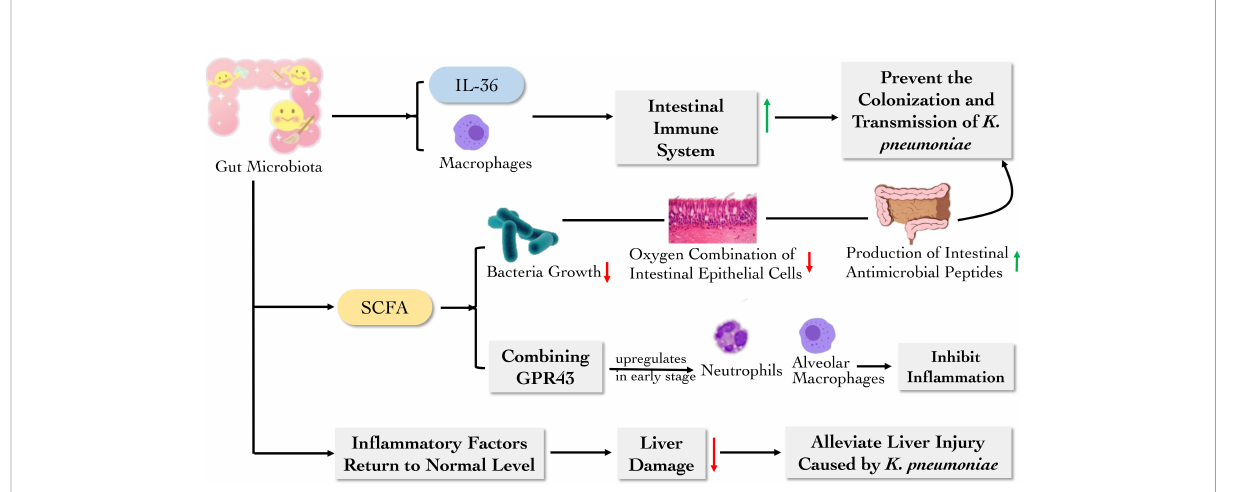
FIGURE 3 The main role of digestive barrier against K. pneumoniae . The gut microbiota and their metabolites can reduce the colonization and transmission of K. pneumoniae and inhibit in fl ammation by regulating the activity of immune cells and in fl ammatory